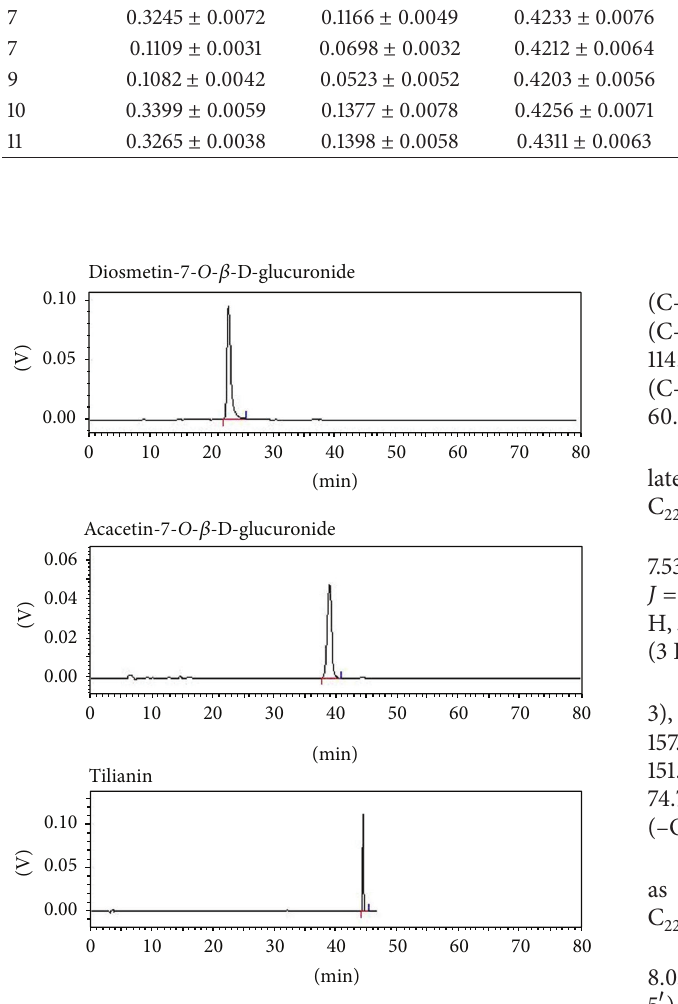
Figure 5: The purities of diosmetin-7- O - 𝛽 -D-glucuronide, acacetin-7- O - 𝛽 -D-glucuronide, and tilianin.